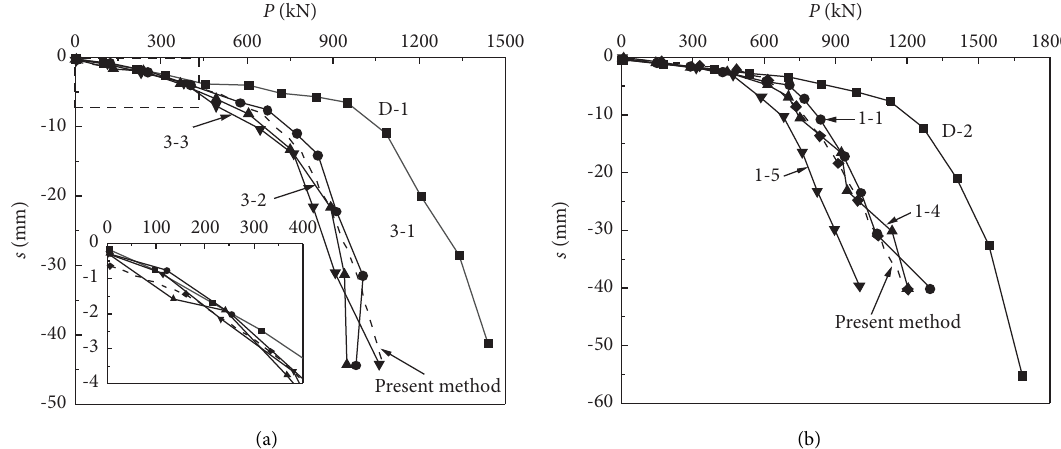
Figure 9: Individual pile load versus group settlement relationship based on the interaction factor. (a) Pile length L � 20m. (b) Pile length L � 24m.